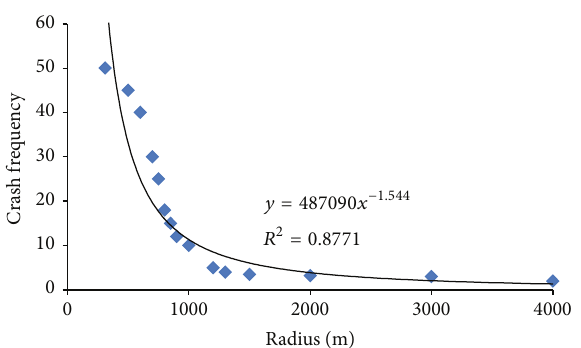
Figure 3: Changes in heart rate of experienced driver passing different sections in SHC. ZH: point of tangent to spiral, ZH − 100: 100 m before ZH, HZ: point of spiral to tangent, HZ + 100: 100m after HZ, H: point of spiral to circle, Y: point of circle to spiral, and QZ: middle point of